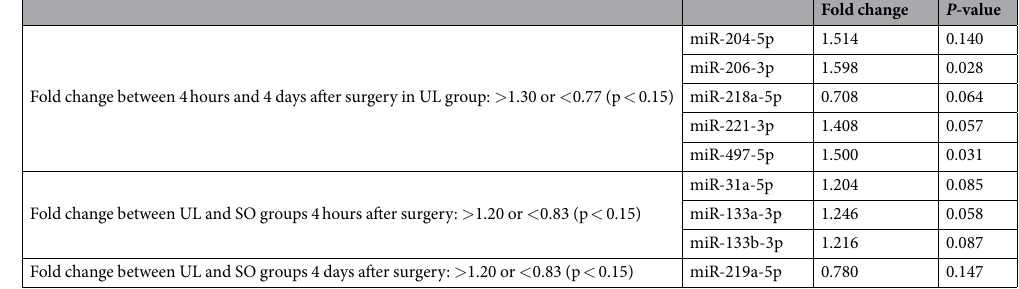
Table 1. Candidate miRNAs selected by microarray analysis. UVD, unilateral vestibular deafferentation; SO, sham